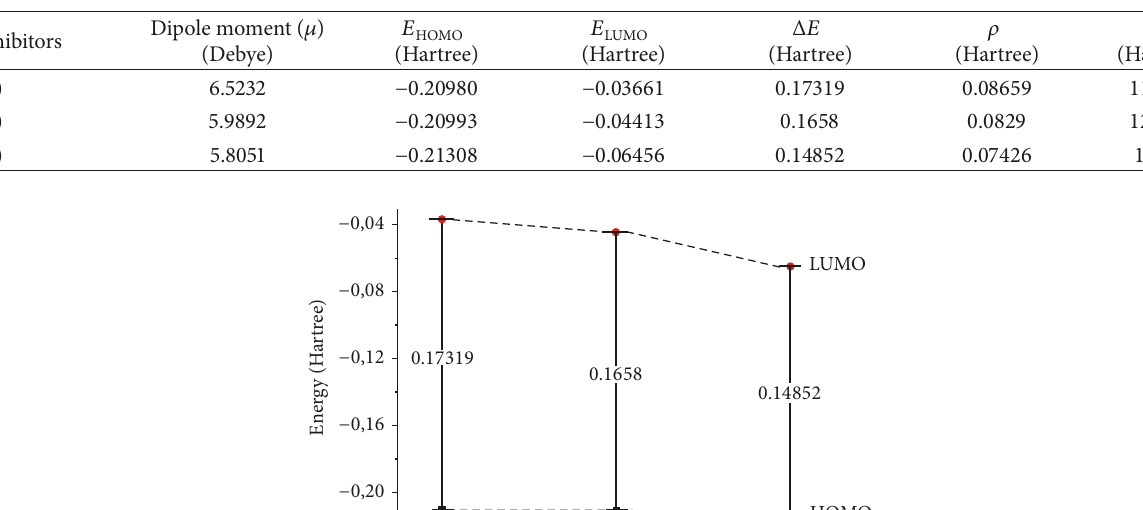
Table 8: Quantum chemical calculation parameters of Camphor thiosemicarbazone (5) , Carvone thiosemicarbazone (6) , and Pulegone thiosemicarbazone (7) , respectively.